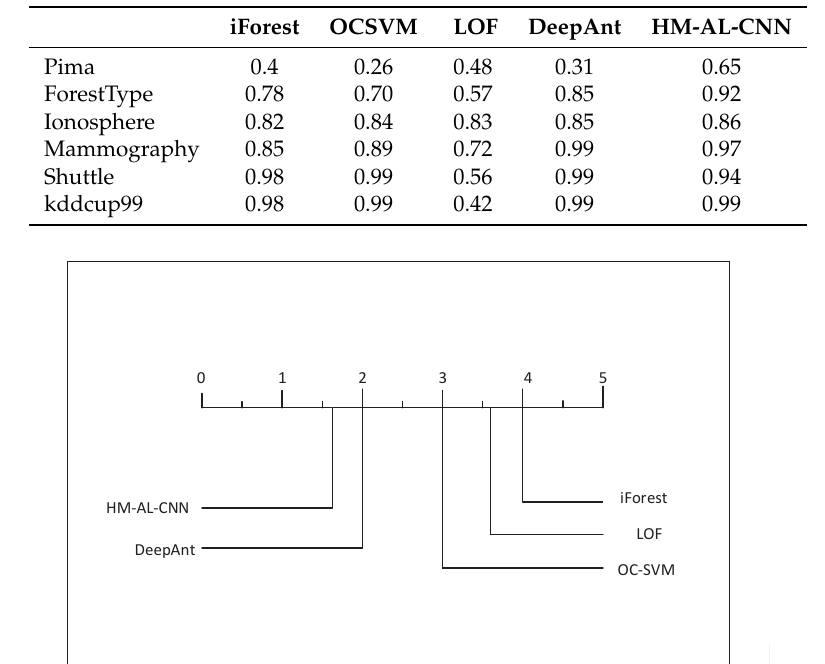
Table 7. Performance comparison of the proposed models with the rest methods on Classic Anomaly-Detection Datasets.